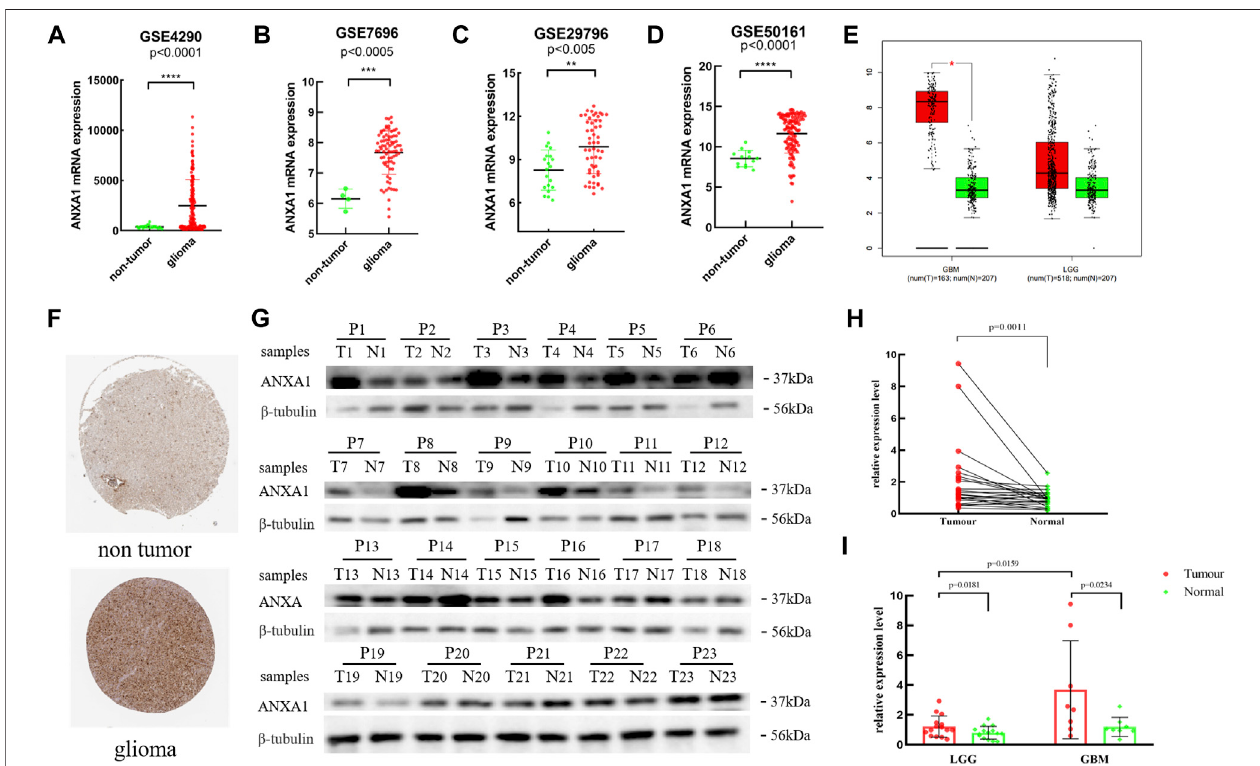
FIGURE 2 | Expression level of the ANXA1 gene in glioma and normal tissues. (A) GSE4290 data set. (B) GSE7696 data set. (C) GSE29796 data set. (D) GSE50161dataset. (E) BasedontheGEPIA onlinewebsite, theexpressionlevel ofANXA1ingliomaand normalsamples. (F) BasedonTheHumanProteinAtlasonline website, the expression level of ANXA1 in the brain tissues of glioma (Intensity: strong; Quantity: 75% – 25%) and normal controls (Intensity: weak; Quantity: 75% – 25%). (G) Western blotting images of 23 glioma tissues and their corresponding paracancerous samples (P1 – P8: GBM; P9 – P23: LGGs). (H) Paired-sample t -test of 23 glioma tissuesand their correspondingparacancerous tissues. (I) Paired-sample t -testofGBM and LGGtumor tissues and theircorrespondingparacancerous tissues, and independent-sample t -test of eight GBM and 15 LGG